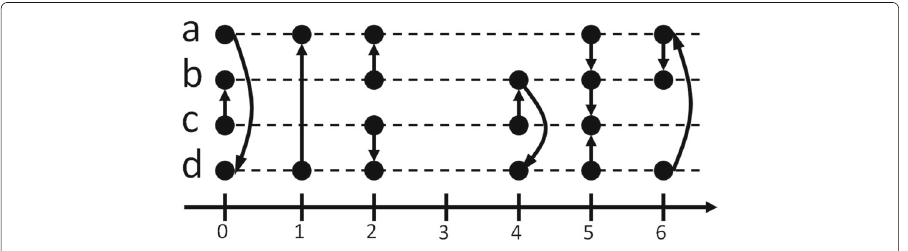
Fig. 2 Example of a directed link stream L = ( T , V , E ) with T = [0,6] ⊆ R , V = { a , b , c , d } , and E = { ( 0, c , b ) , ( 0, a , d ) , ( 1, d , a ) , ( 2, b , a ) , ( 2, c , d ) , ( 4, c , b ) , ( 4, b , d ) , ( 5, a , b ) , ( 5, b , c ) , ( 5, d , c ) , ( 6, a , b ) , ( 6, d , a )